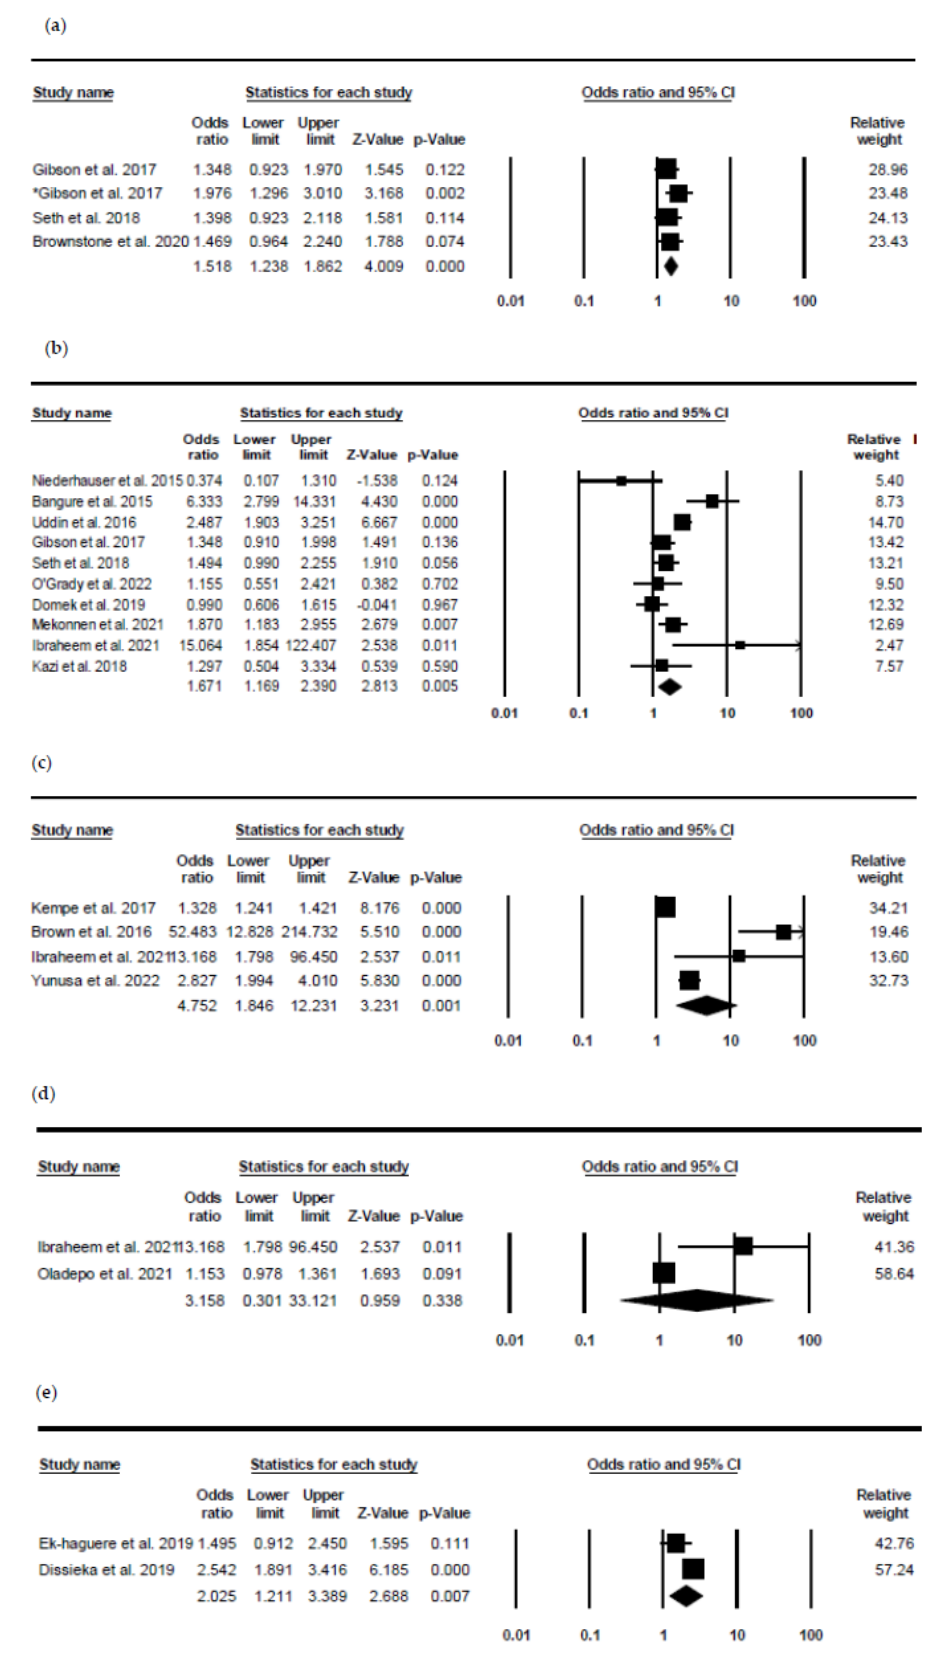
Figure 2. Forest plot of interventions on immunisation coverage. ( a ) SMS reminder and incentive on coverage: Heterogeneity: Q-value = 2.051, p -value = 0.562, I-square 0.000 [31,32,36]. ( b )